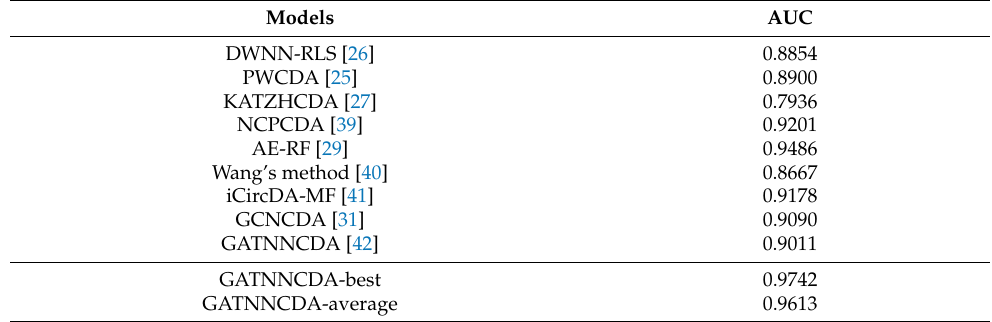
Table 3. The fivefold CV AUC comparison with the other nine methods based on CircR2Disease